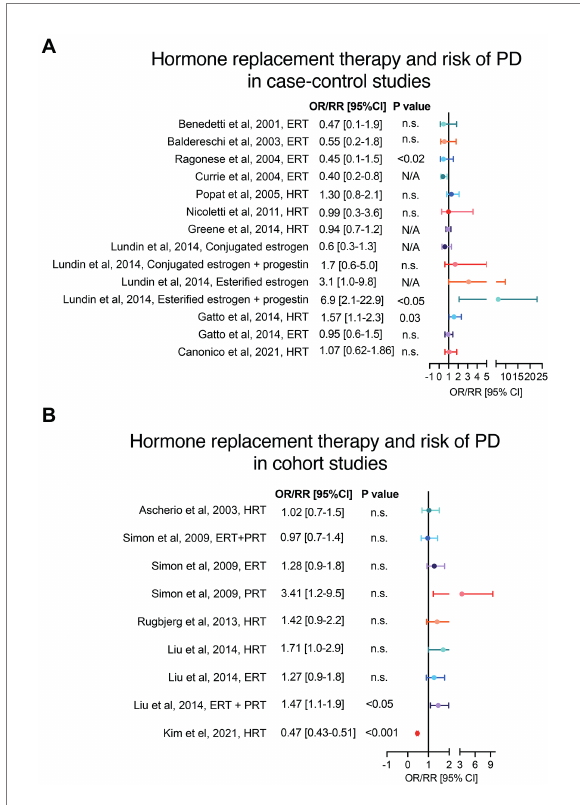
FIGURE 3 Hormone replacement therapy and risk of PD. Panels (A,B) show case–control and cohort studies, respectively, that have analysed the risk of PD in women with history of HRT. Adjusted OR/RR and 95% CI with level of statistical significance ( p value). OR = odds ratio, RR = relative risk, 95% CI = 95% confidence of interval, HRT = hormone replacement therapy, ERT = estrogen replacement therapy, PRT = progesterone replacement